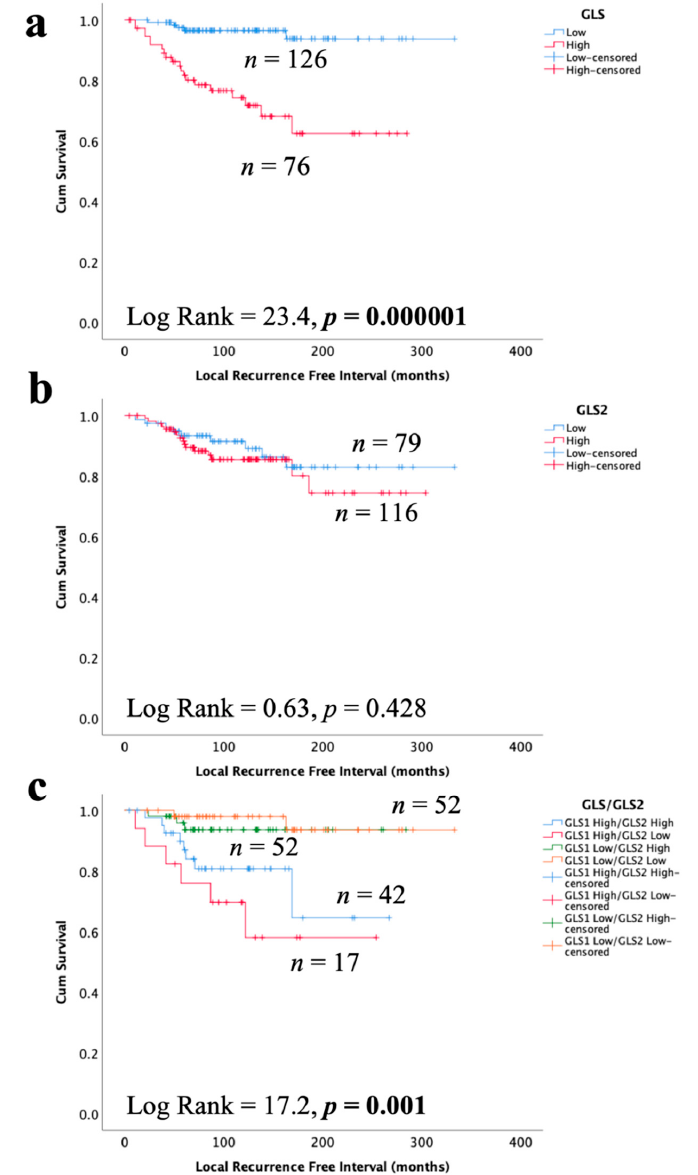
Figure 6. Kaplan–Meier of GLS and GLS2 protein expression with tumour recurrence in ER +/HER2- DCIS patients: ( a ) GLS, ( b ) GLS2, and ( c ) combined expression of GLS and GLS2. Statistically significant p values are in bold. Table 5. Multivariate survival analysis of variables predicting LRFI for GLS and GLS/GLS2 protein co-expression in ER +/HER2- DCIS.